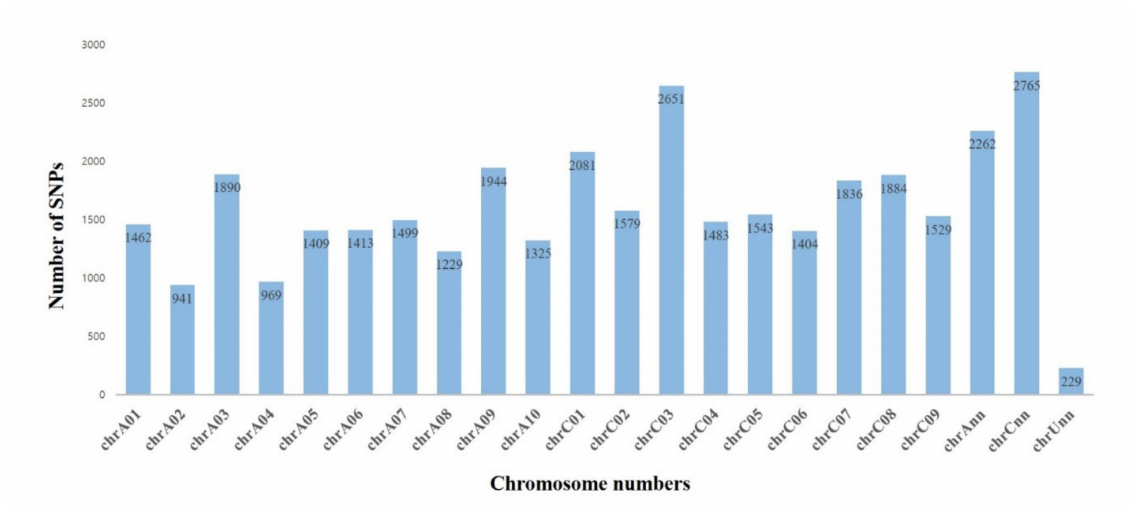
Figure 2. Chromosomal distribution of the 35,397 union SNPs from GBS in gamma-irradiated rapeseed mutant lines. The union SNPs were combined from the 277,036 mutational changed SNPs. Reference genome sequence: Brassica napus V5.1